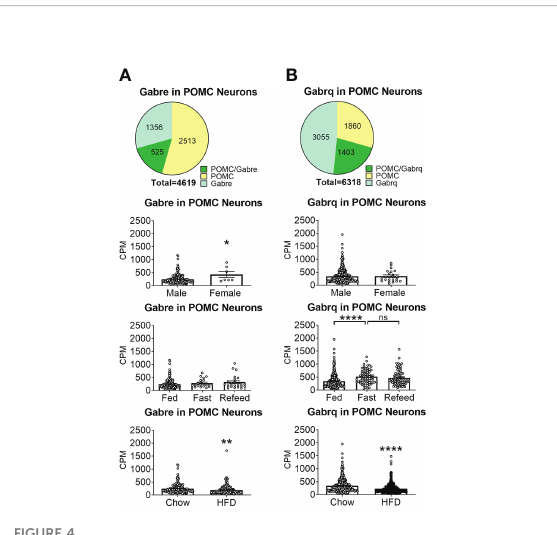
FIGURE 4 The expression of Gabre and Gabrq subunits GABA A receptors in ARH POMC neurons. (A) Gabre and (B) Gabrq. Pie graphs and bar graphs were made the same way as described in Figure